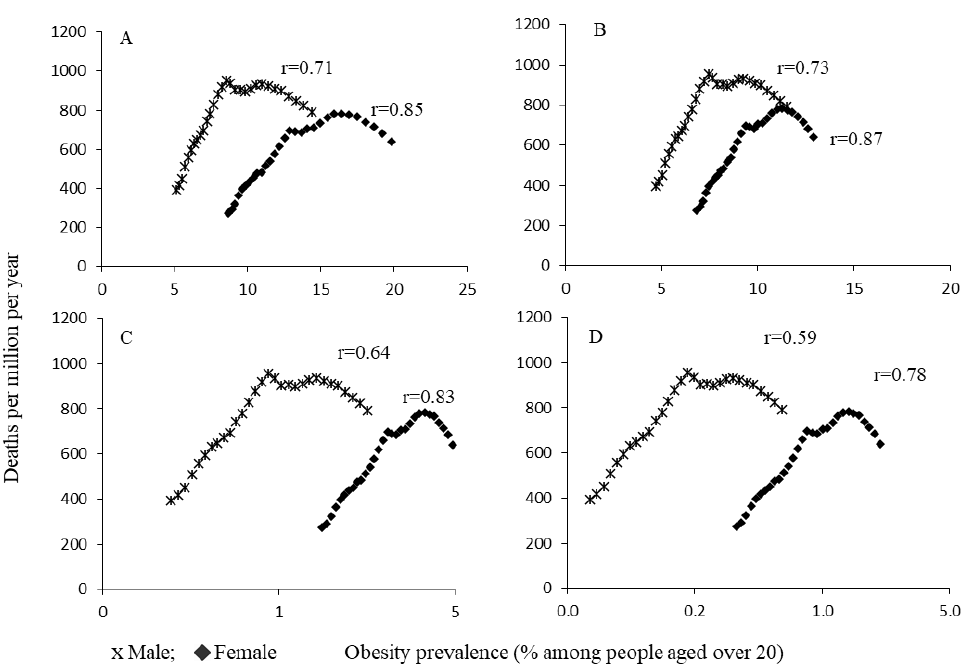
Figure 3. Ecological relationships between incidence rates of ischemic heart disease and obesity prevalence. ( A ) Obesity (BMI > 30); ( B ) Class I (BMI = 30 – 34.9); ( C ) Class II (BMI = 35 – 39.9); ( D ) Class III (BMI ≥ 40).